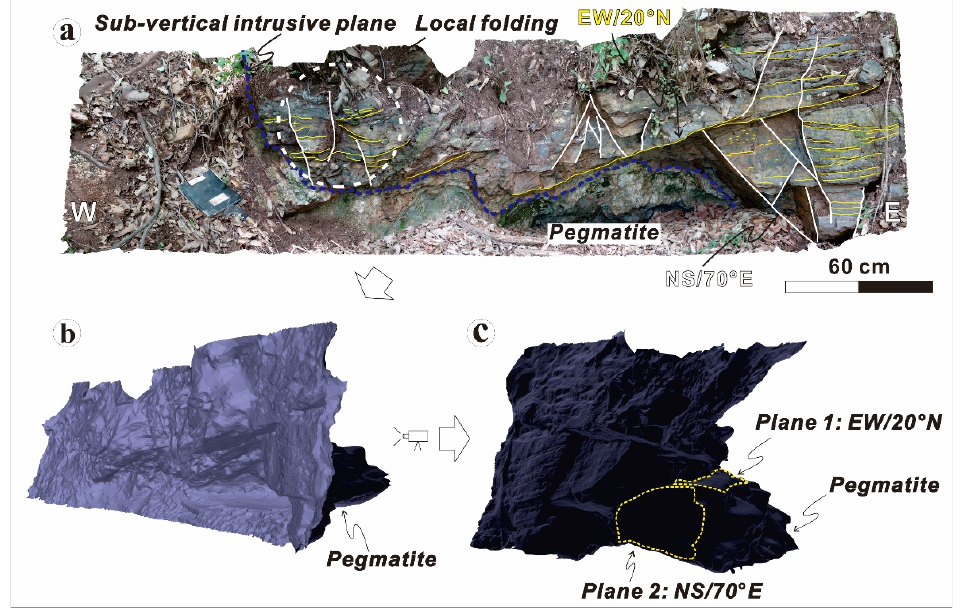
Figure 8. Rare ‐ element pegmatite (REP) body Pgt 6 in a small open pit. ( a ) The REP body is zig ‐ zag shaped with EW/20° N ‐ striking bedding and NS/70° E ‐ striking fractures. ( b , c ) Solid images produced using Agi software. The mine shape shows the interrelationship between bedding and fractures.